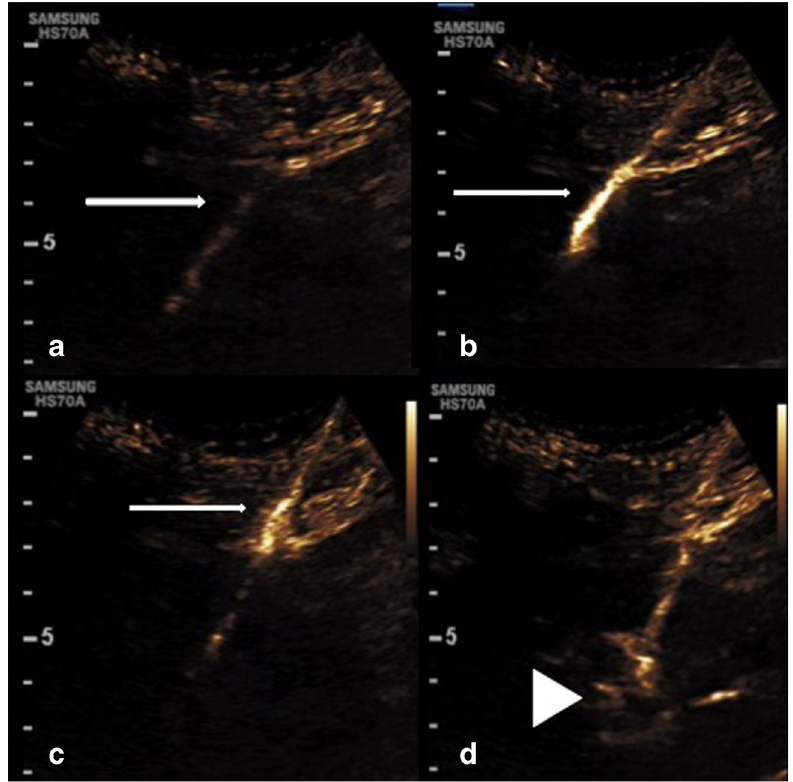
ultrasound contrast placed within a Chiba needle. On puncture of a hydro-nephrotic kidney reflux of contrast (A – C, arrow) is shown being ‘ pushed ’ out by fluid (urine) held under pressure within an obstructed renal pelvis (arrows). Ultrasound contrast is then injected along the Chiba needle to confirm correct needle position and to opacify the renal pelvis (D,